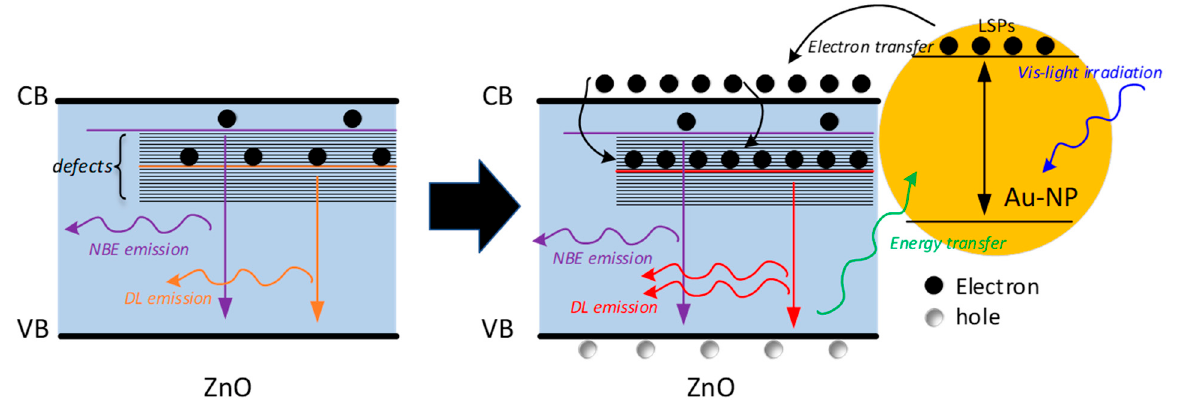
Figure 10. Schematic of electron transfer in energy band diagram of ZnO NRs/Au NPs with localized surface plasmon of Au NPs according to the PL spectra.